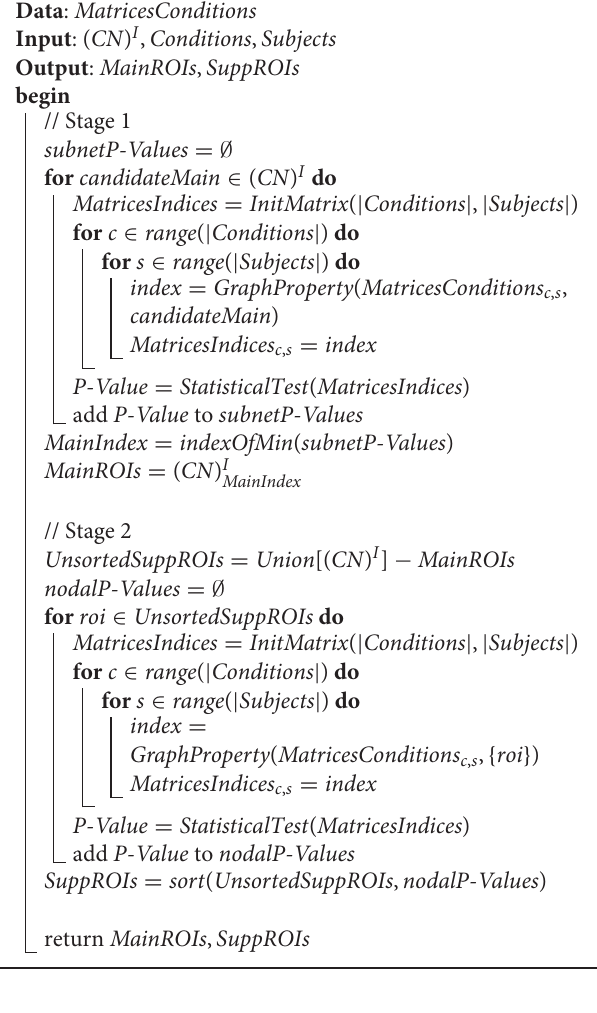
TABLE 1 | Combined fronto-parietal network. Cognitive network